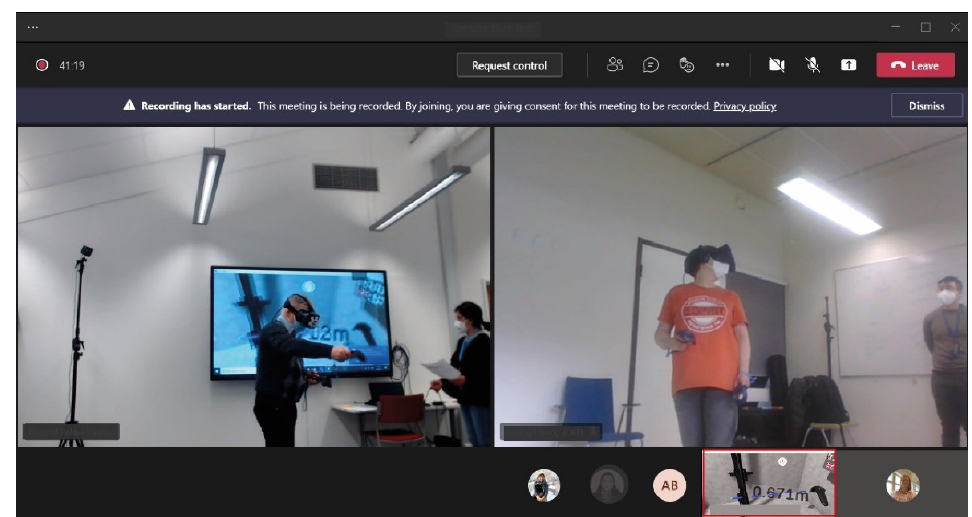
Figure 14. Multi-user VR session using Teams in Case 5. Two VR rooms are shown as the large images, and the HMDe view is in the small image on the bottom right.